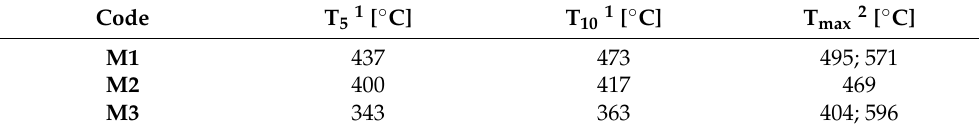
Table 1. Thermal stability of M1–M3 .